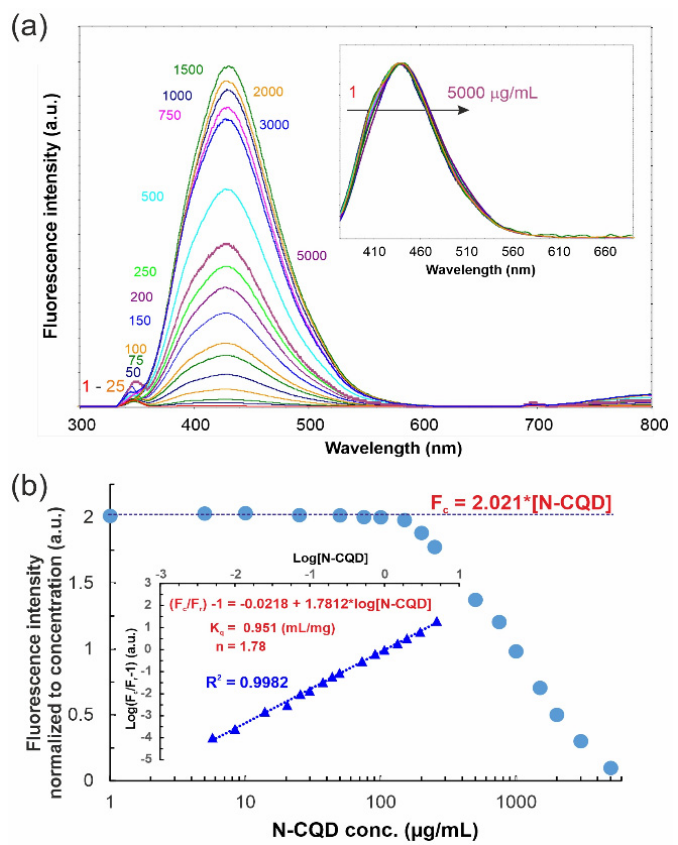
Figure 3. ( a ) Fluorescence spectra for different concentrations of synthesized N-CQDs (the numbers denote the concentration in µ g/mL) indicate that, for the concentrations above 1500 µ g/mL, the intensity decreases with increasing N-CQD concentration; inset shows normalized spectra showing lack of the emission band shifting. ( b ) Normalized to concentration fluorescence intensity as a concentration function; inset shows modified Stern–Volmer plots for quenching of various concentrations of N-CQD solution. Fc are the fluorescence intensities extrapolated in accordance to Lambert–Beer law while Fr means real observed intensities.